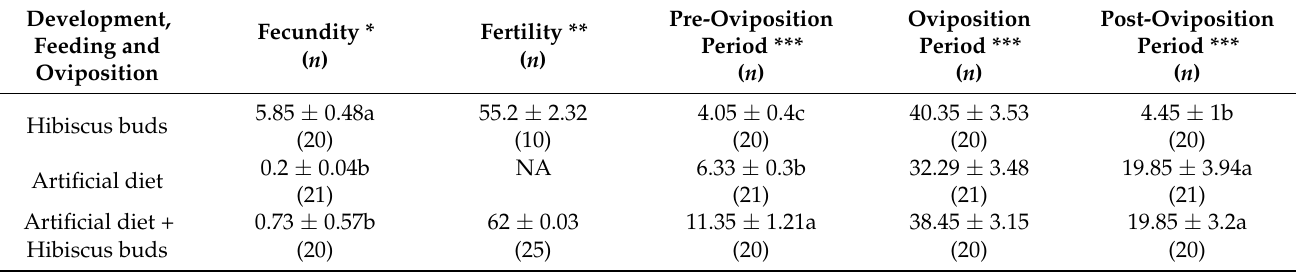
Table 3. Reproductive parameters for the hibiscus bud weevil ( Anthonomus testaceosquamosus ) when it developed, fed, and reproduced solely on hibiscus buds, on the artificial boll worm diet, or when it developed on the diet and reproduced on hibiscus buds. Within each column, different letters indicate significant differences (Tukey, p < 0.05).